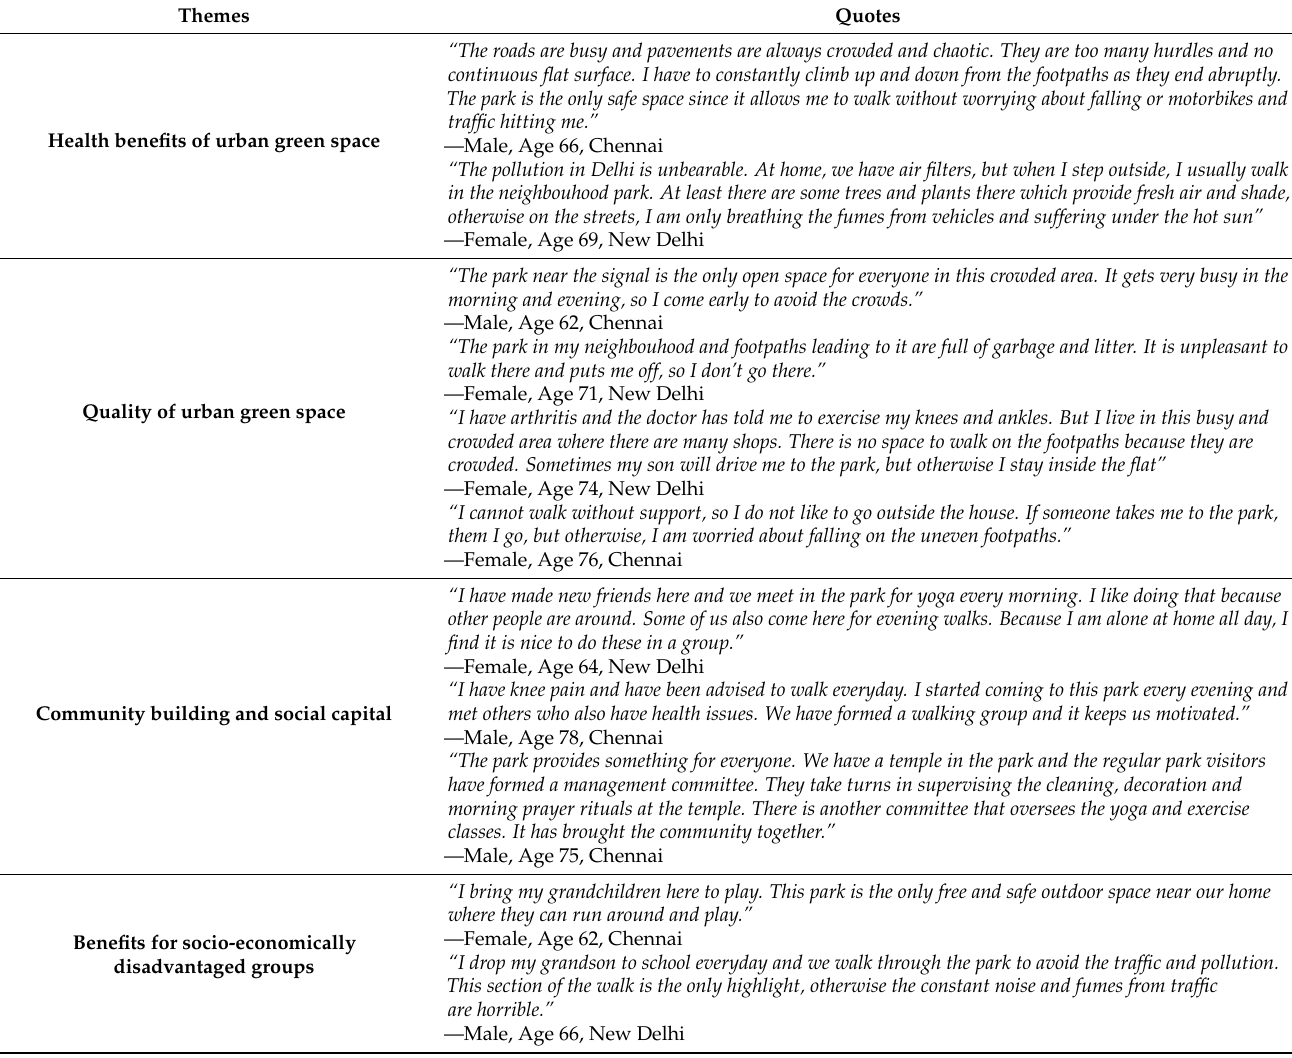
Table 2. Summary table of themes and sample quotes ( N = 60) highlighting perspectives on urban green spaces and ageing in New Delhi and Chennai,